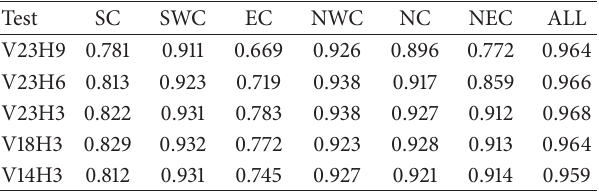
Table 3: Spatial correlation coefficients of SAT for the V23 and H3 Schemes at different resolutions for the